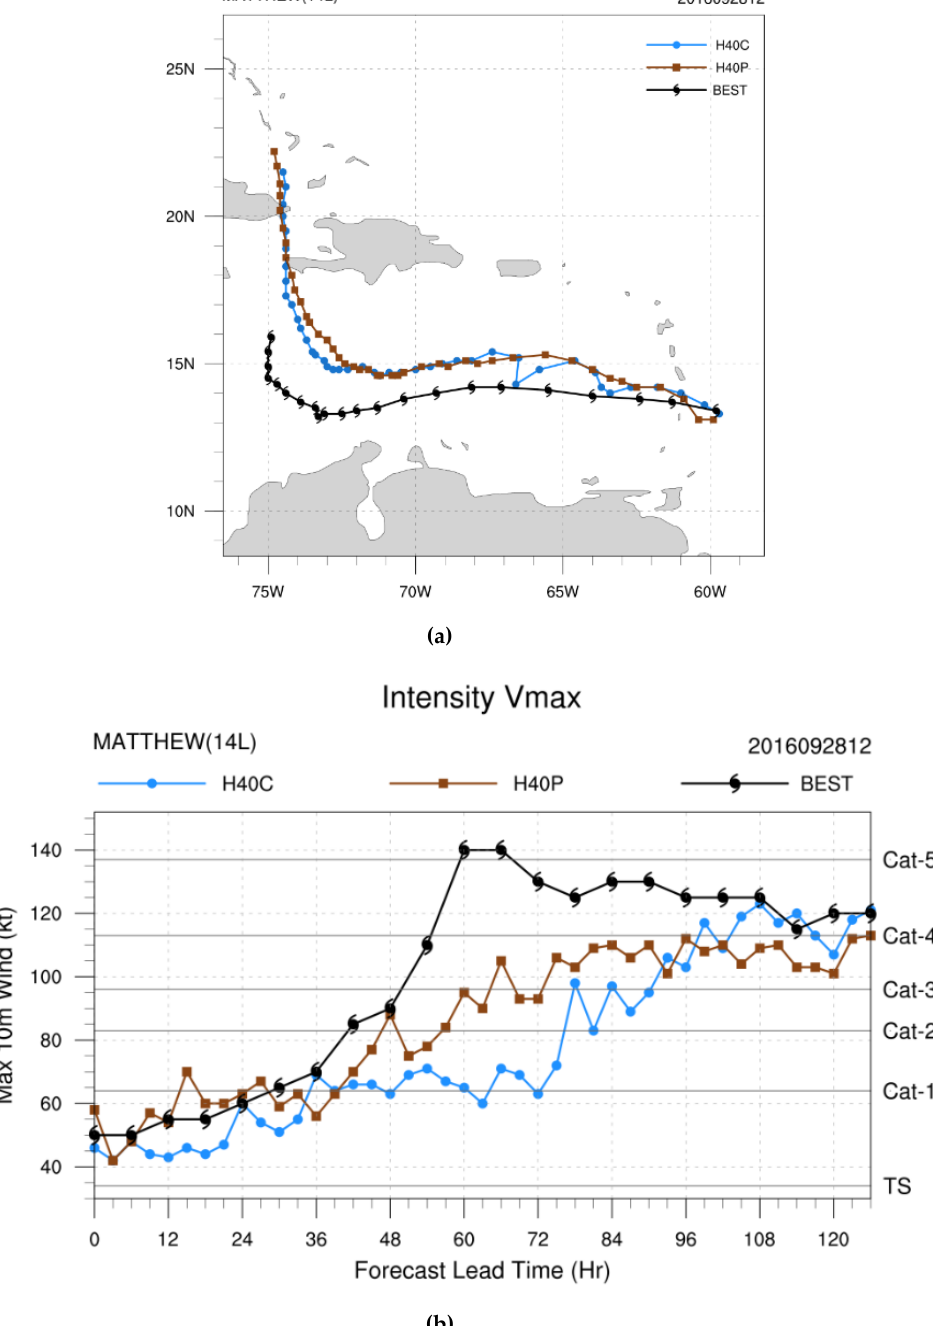
Figure 10. An example of 5-day track ( a ) and intensity ( b ) forecast comparisons between the H40C and the H40P for Hurricane Matthew 14 L, 00:12 UTC 28 September 2016. TC: Tropical Cyclone.